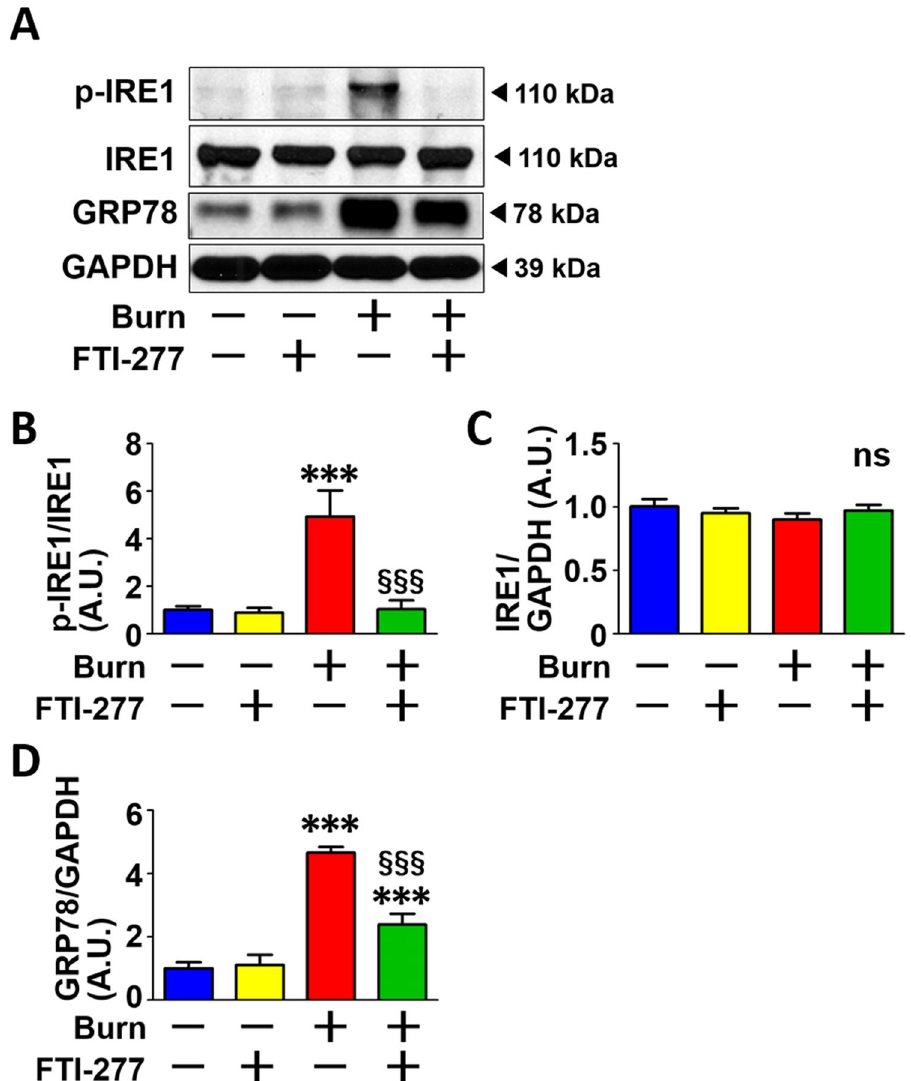
Figure 8. FTI-277 inhibited burn-induced ER stress in skeletal muscle. Burn injury significantly increased phosphorylation of IRE1 ( A , B ) and Grp78 protein expression ( A , D ) compared with sham-burn. FTI-277 mitigated burn-induced increases in phosphorylation of IRE1 and protein expression of Grp78. IRE1 protein expression was not altered by burn injury or FTI-277. *** P < 0.001 vs. sham-burn groups, §§§ P < 0.001 vs. vehicle-treated burn group. n = 6 mice per